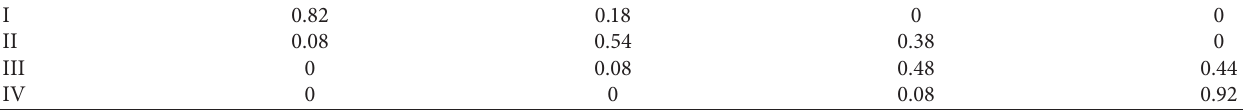
Table 13: Subjective evaluation index membership evaluation